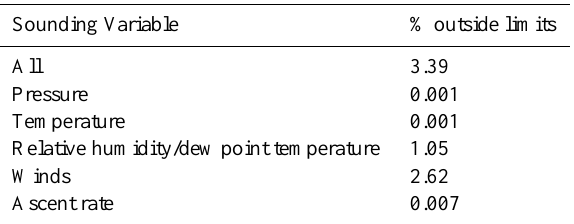
Table 4. Data quality check failure rate. Summary of the percent- age of observations for all sites outside of the data quality checked defined in Table